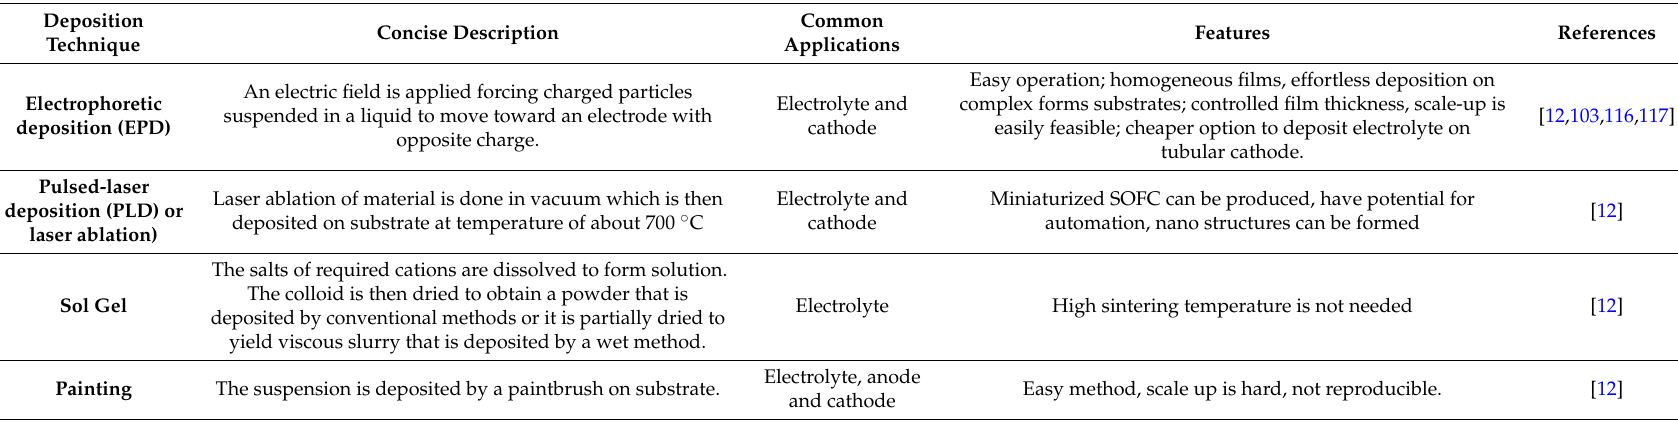
Table 5. Electrical performance of SOFC with different materials